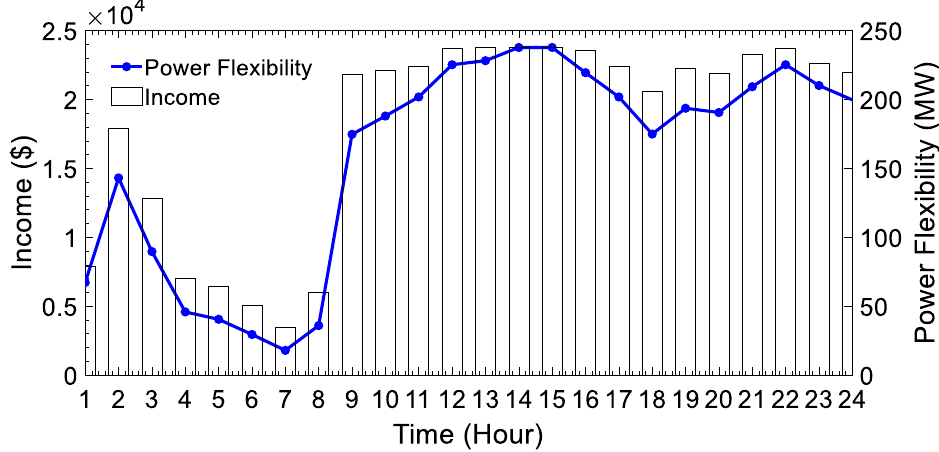
Figure 17. Benefits of selling electricity to the market in terms of income and power flexibility.